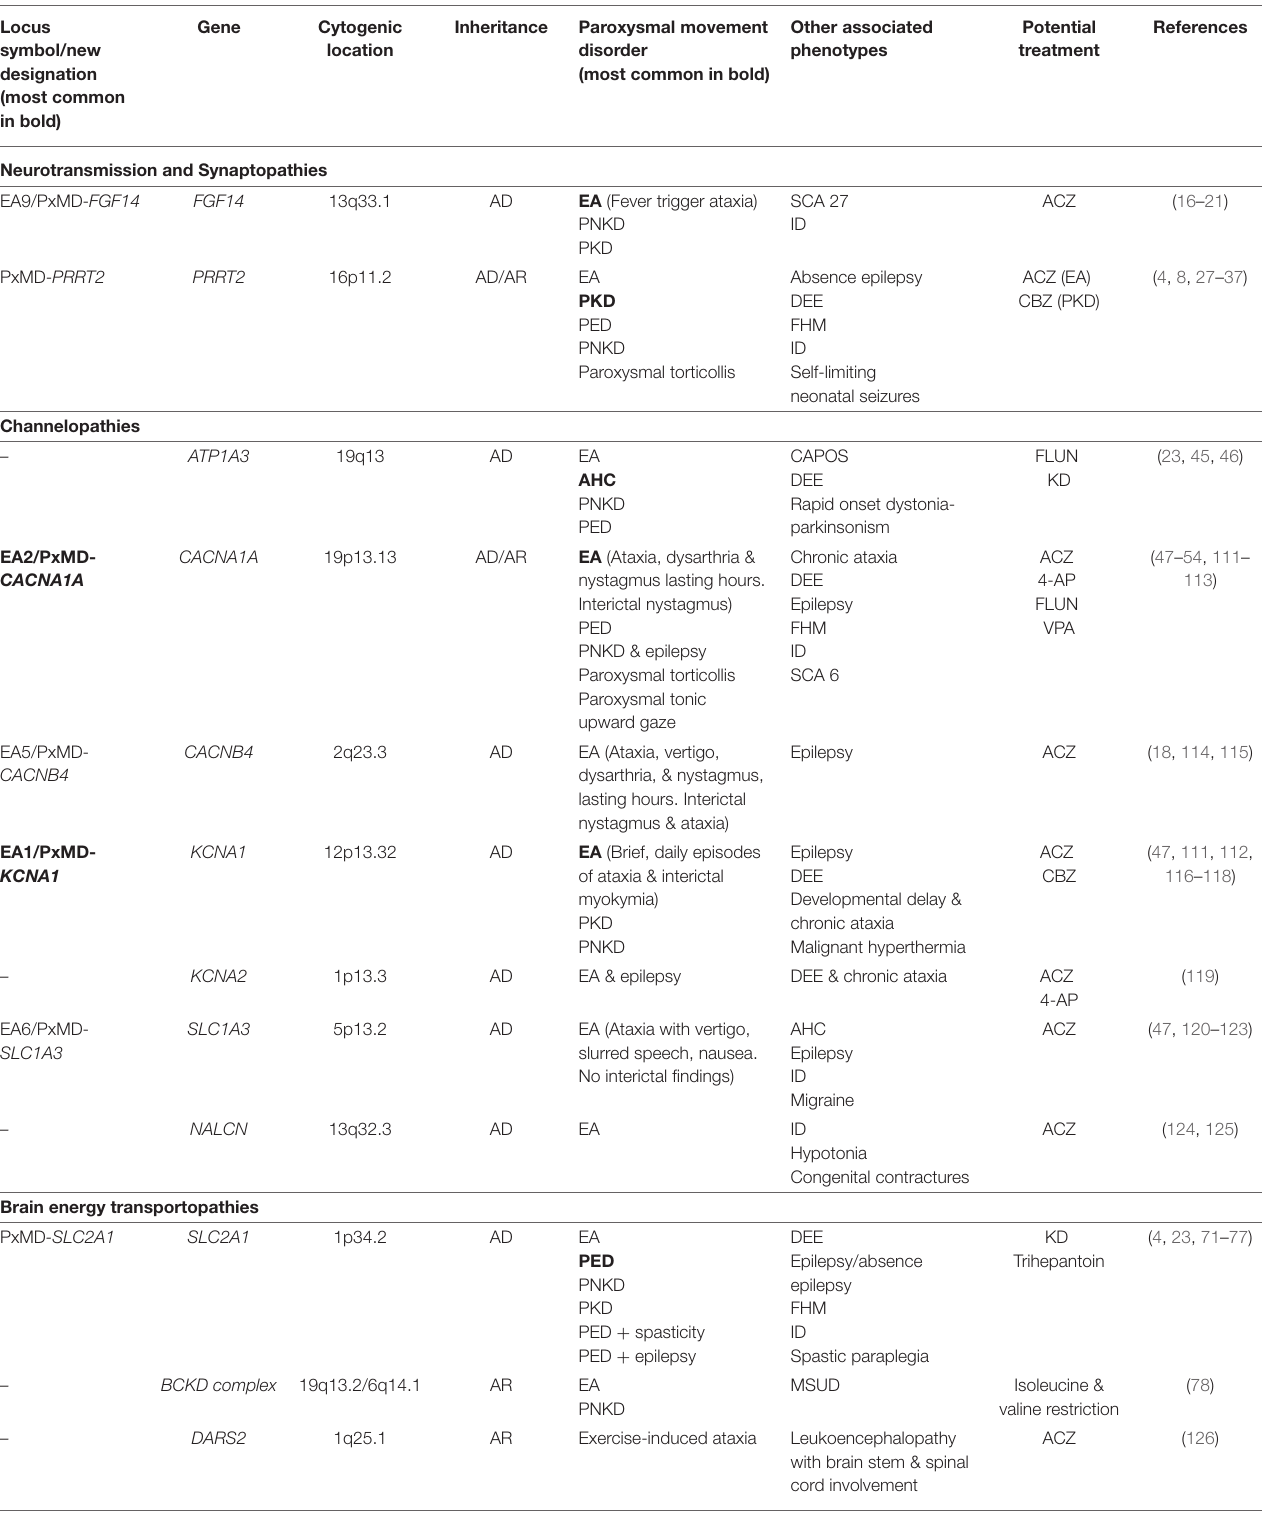
TABLE 2 | Predominant episodic ataxia genes. Locus symbol/new designation (most